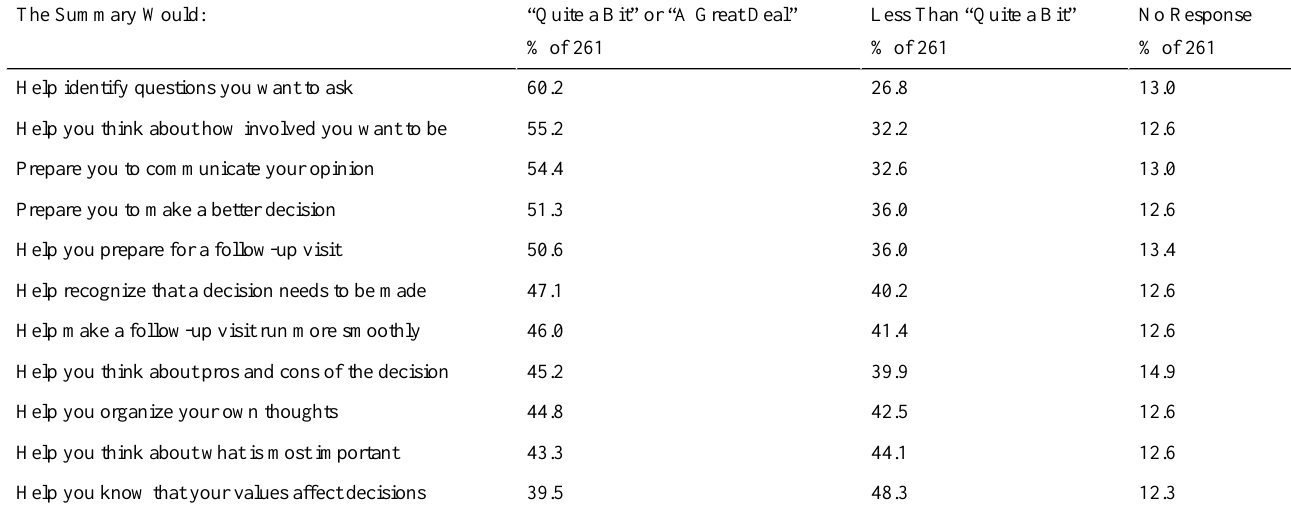
Table 5. Percentage of respondents by satisfaction with preparation for decision